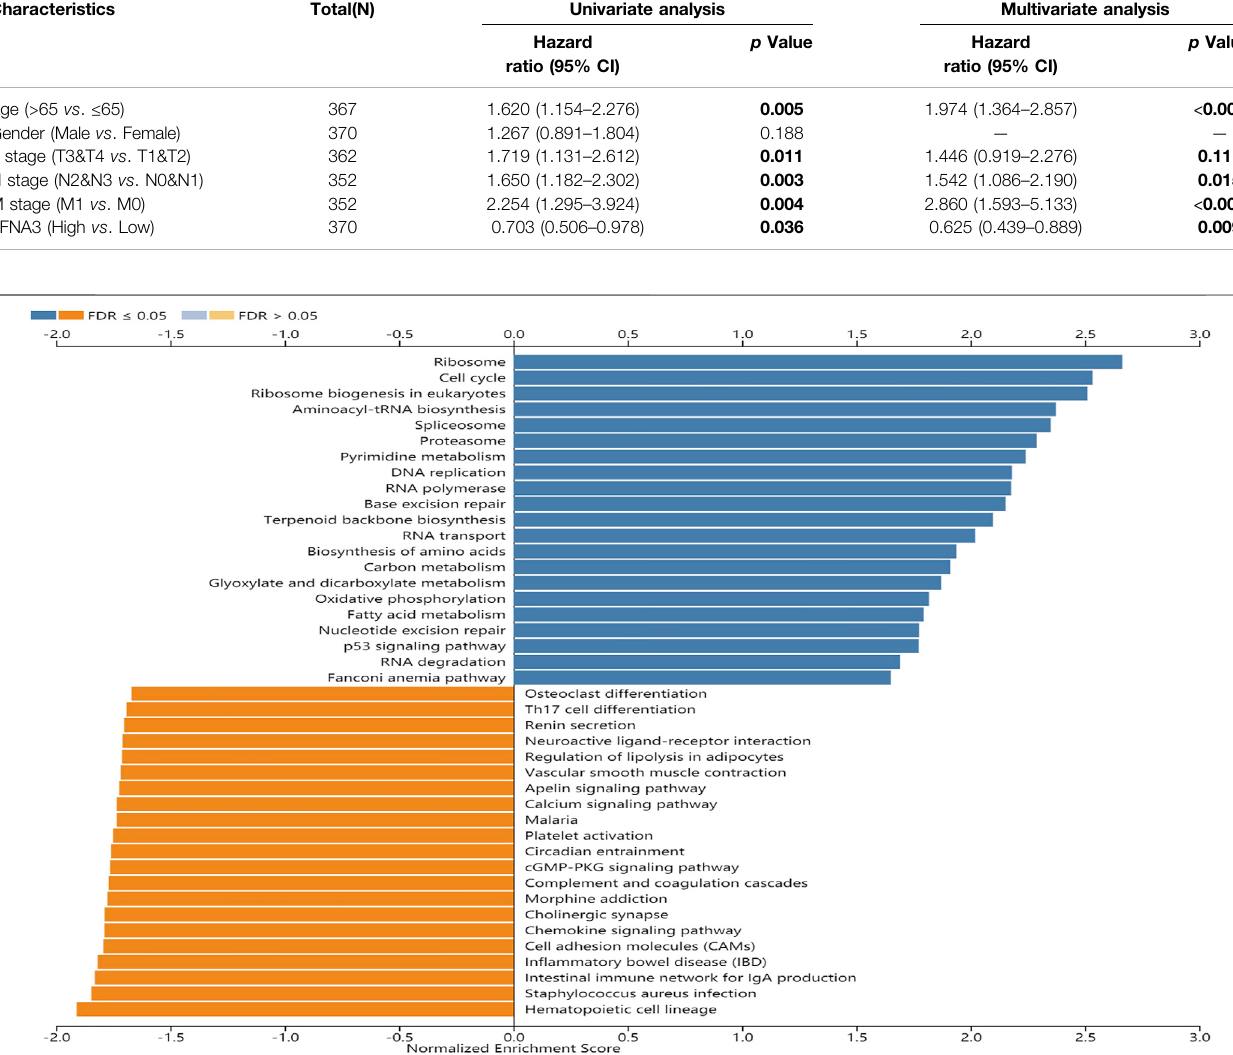
FIGURE 3 | Enrichment plots from GSEA. KEGG pathways of EFNA3 in STAD cohort. FDR, false-discovery rate.